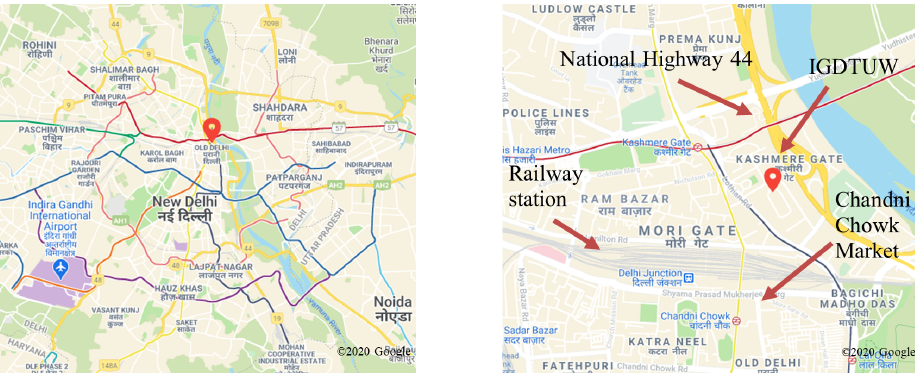
Figure 1. The measurement site (IGDTUW) in Old Delhi, north of New Delhi (left). In closer detail (right), the site was just north of the Delhi Junction Railway Station, and west of National Highway 44. Map data © Google Maps